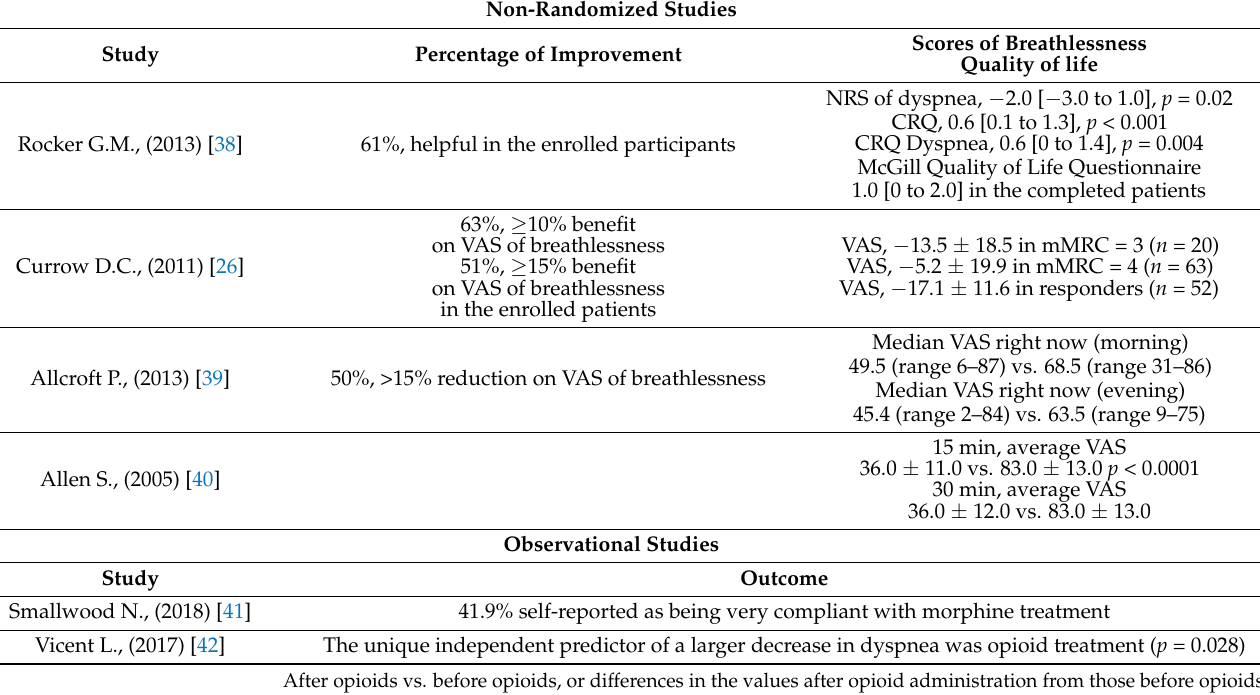
Table 5. Outcomes of non-randomized or observational studies of systemic opioids for